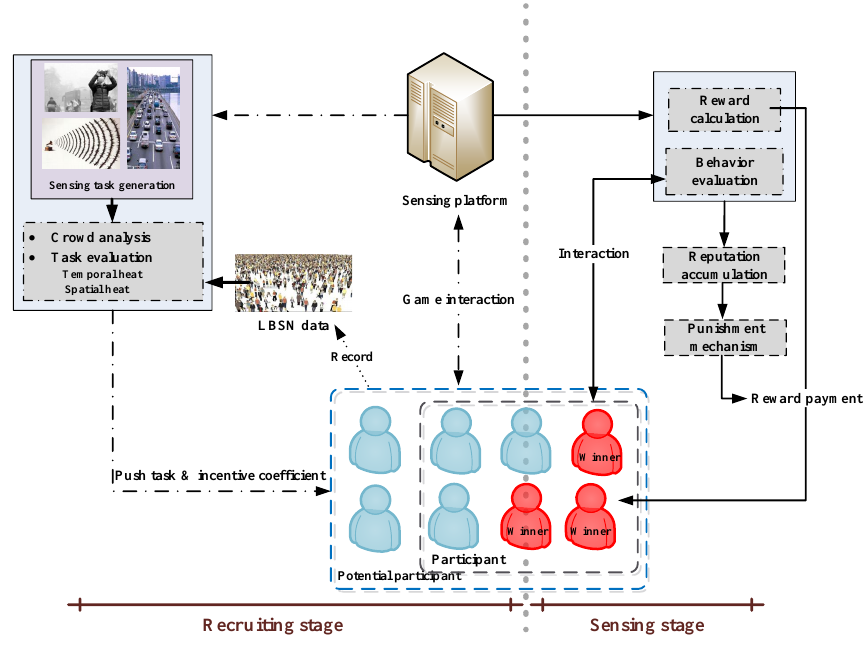
Figure 5. Staged incentive mechanism